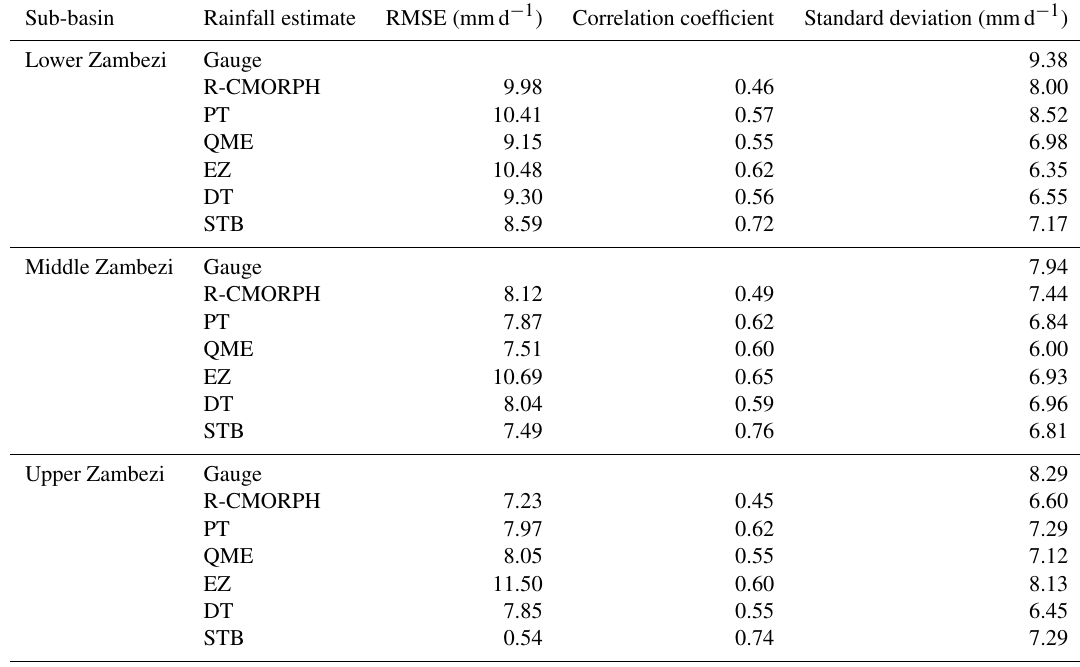
Table A2. Bias-correction scheme-based Taylor diagram performance indicators (correlation coefficients, standard deviations, and RMSE) of rain-gauge (reference) vs. CMORPH estimations (corrected and uncorrected), period 1998–2013, for the Lower, Middle, and Upper Zambezi